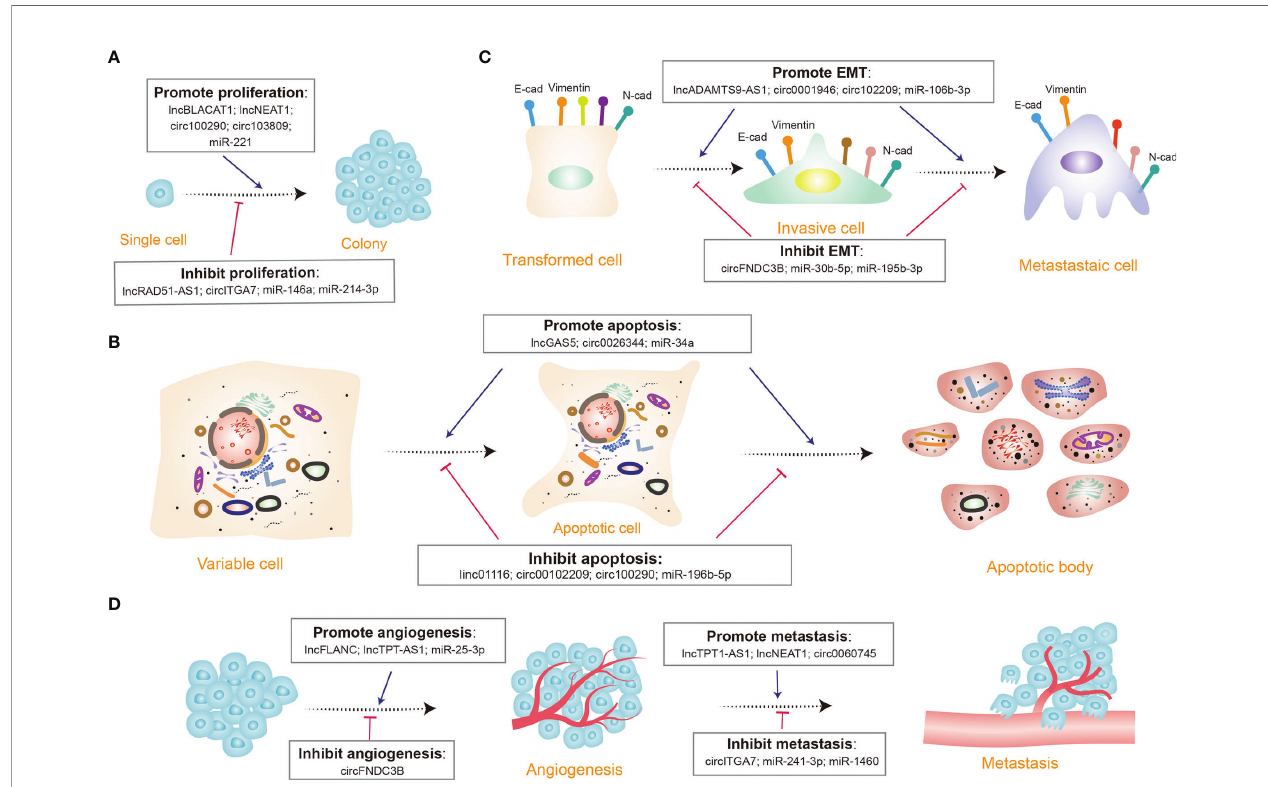
FIGURE 3 | Diverse functions of non-coding RNAs (ncRNAs) in colorectal cancer. (A) A few ncRNAs regulate cell proliferation by promoting (e.g., lncBLACT1) or inhibiting cell proliferation progression (e.g., circITGA7). (B) Many ncRNAs modulate cell apoptosis via triggering (e.g., lncGAS5) or curbing (e.g., miR-196b-5p) cell apoptosis. (C) Several ncRNAs control the epithelial-mesenchymal transition (EMT) process through inducing (e.g., circ102209) or repressing (e.g., miR-30b-5p) EMT; E-cad, E-cadherin; N-cad, N-cadherin. (D) Certain ncRNAs manipulate tumor angiogenesis and metastasis procedure, some appear to facilitate tumor angiogenesis (e.g., lncFLANC), while others restrain (e.g., circFNDC3B) the process; some promote metastasis (e.g., lncTPT1-AS1), while others inhibit (e.g., miR-1460) the